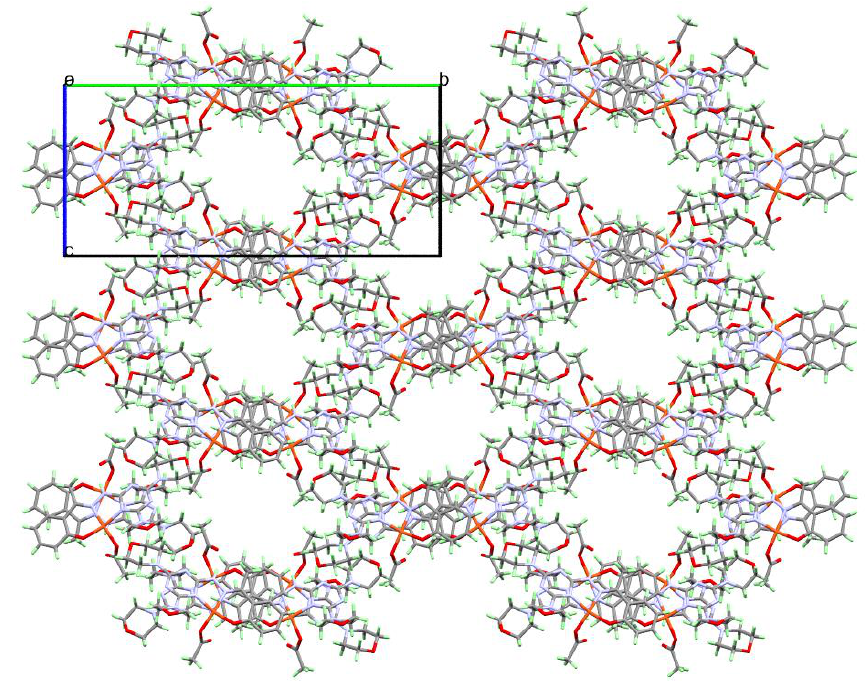
Figure 7. Packing scheme of the complex units of 2 . In such tubular structures, these spaces are